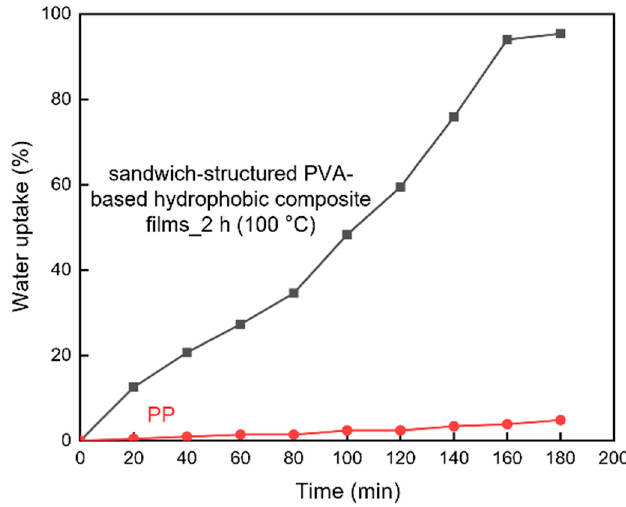
Figure 17. Water uptake behavior of the sandwich-structured PVA-based hydrophobic composite film and a commercial PP specimen.